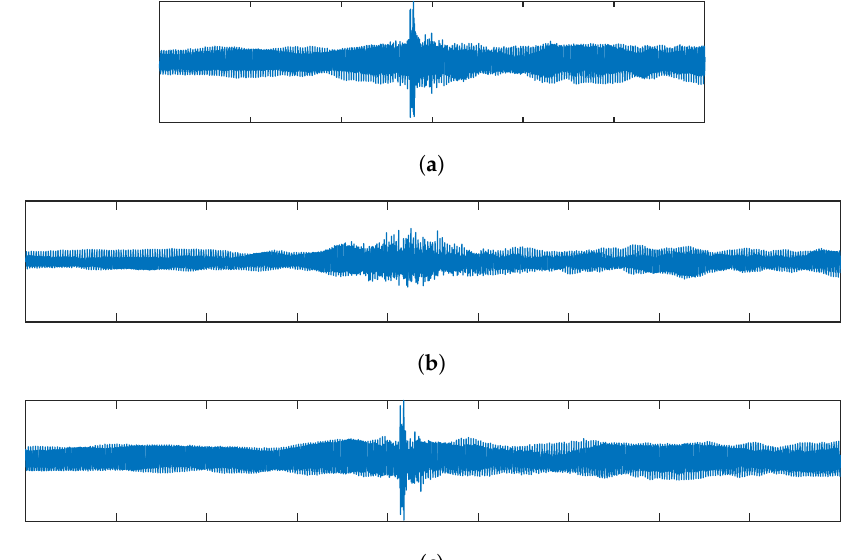
( c ) Figure 7. An example of the proposed transient preservation method. ( a ) shows the original audio, consisting of a solo violin overlaid with a castanet click. Also shown are the modified samples with TSM factor α = 1.5, using ( b ) the standard phase vocoder, and ( c ) the proposed